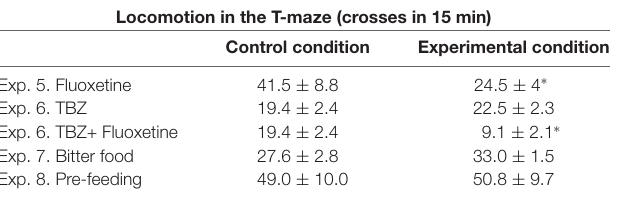
TABLE 2 | Effect of tetrabenazine (TBZ) and fluoxetine alone or in combination, and food manipulations on general locomotion. Locomotion in the T-maze (crosses in 15